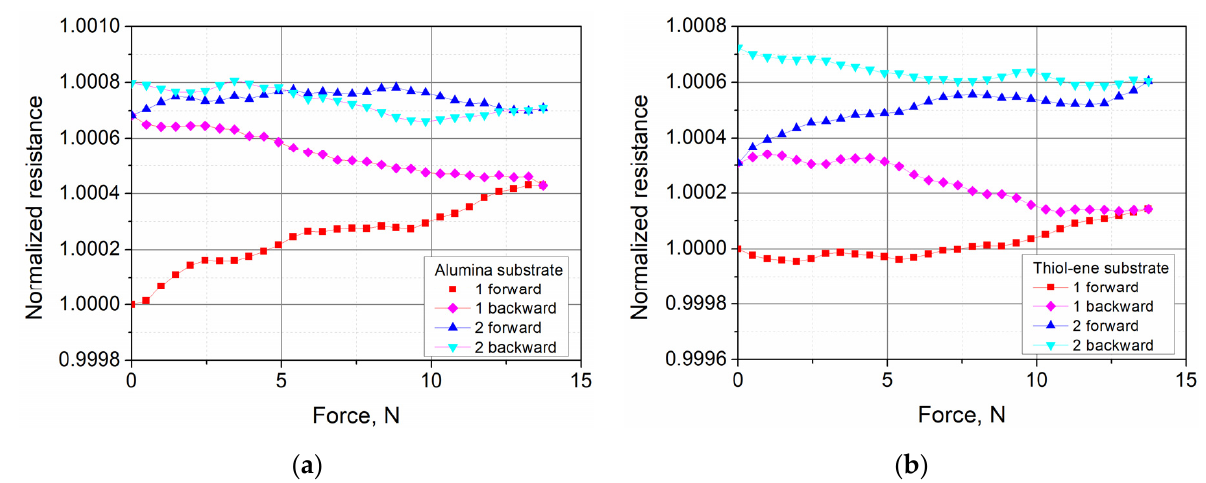
Figure 9. Dependence of the normalized resistance of PEDOT:PSS films on the applied force during the first two cycles of loading: ( a ) alumina substrate and ( b ) thiol–ene substrate on alumina. The notation “forward” means an increase in force, while “backward” means a decrease.